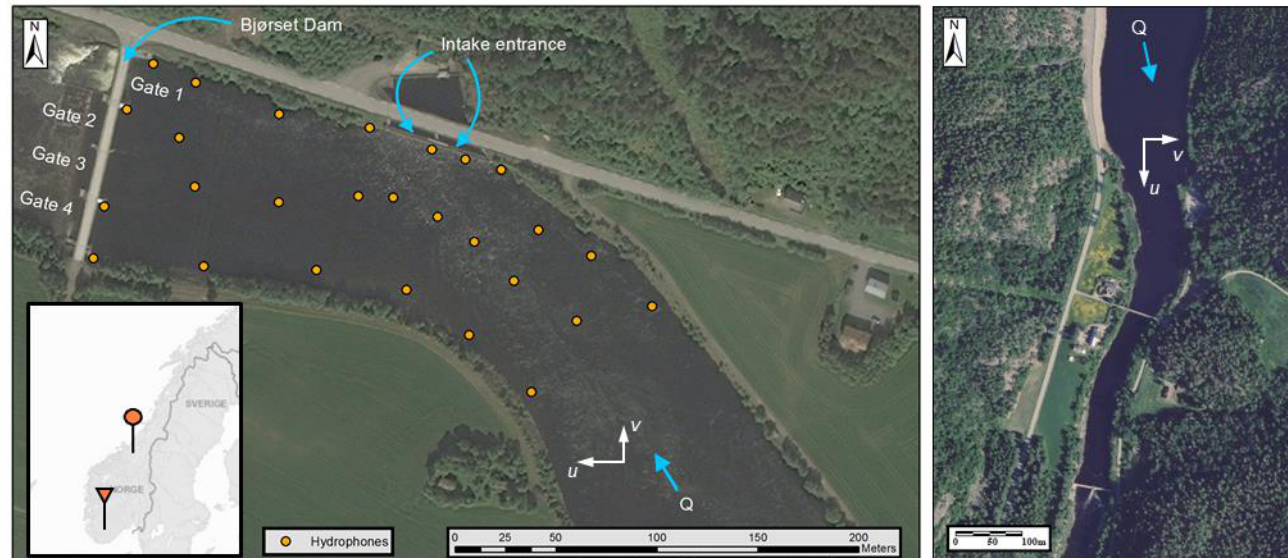
Figure 1. The study site at the Bjørset dam on the River Orkla with the location of the twenty-seven hydrophones (left panel) and the study site at the Laudal hydropower plant [11] (right panel). Insets show the location of sites (bottom-left, circle marker: River Orkla; triangle marker: River Mandal). The main flow directions ( Q ) are presented beside the u and v flow vectors defined along the Cartesian grid to represent the dominant longitudinal ( u ) and transversal ( v ) velocities accordingly. Source: ArcGIS ® software by ESRI (www.esri.com; accessed on 1 April 2018) and Norge i Bilder (www.norgeibilder.no; accessed on 1 December 2019).